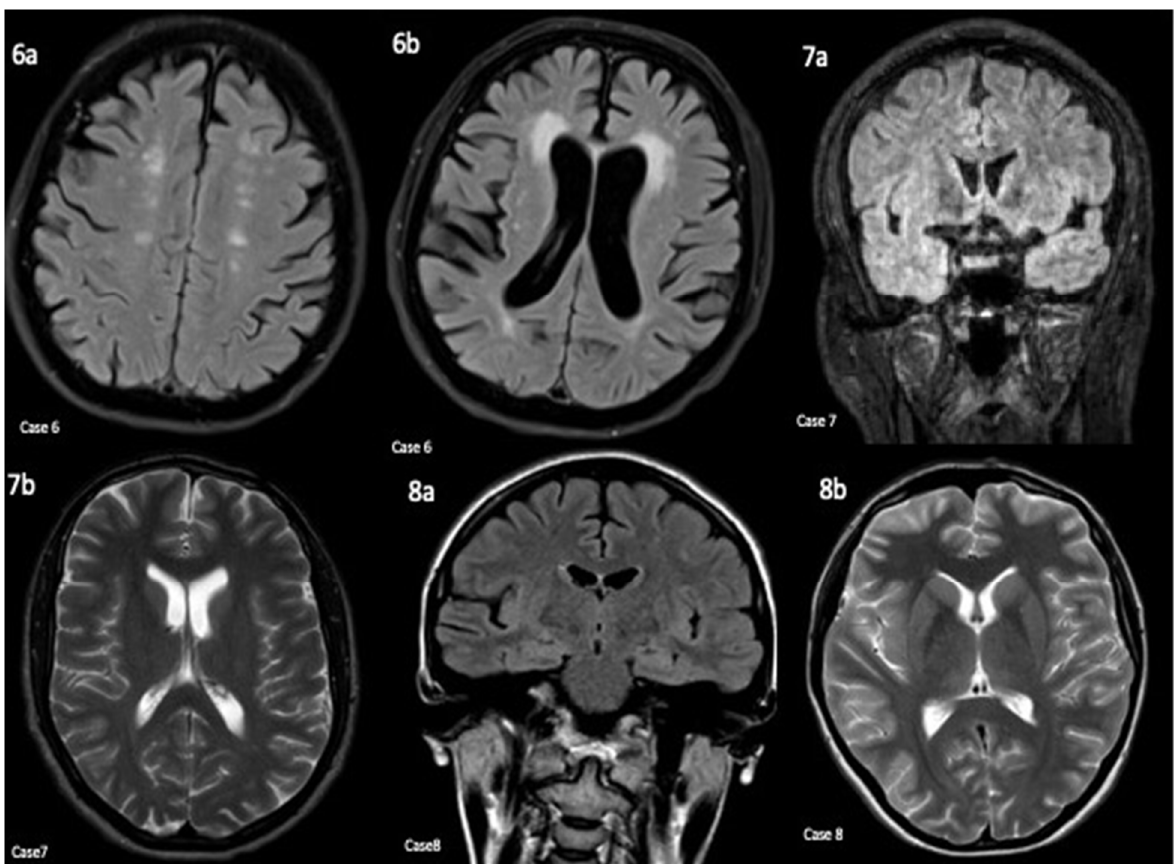
Figure 3. CASE 6: Axial FLAIR ( 6a , 6b ) sequences. Moderate to advanced generalized parenchymal volume loss without focal signal abnormality involving the mesial temporal lobes. There was also advanced white matter chronic microvascular ischemic changes. CASE 7: Coronal FLAIR ( 7a ) and axial T2 sequence. Normal appearance of the mesial temporal lobes. The rest of the examination was also normal. CASE 8: Coronal & Axial FLAIR/T2 ( 8a , 8b ) sequence. Normal examination